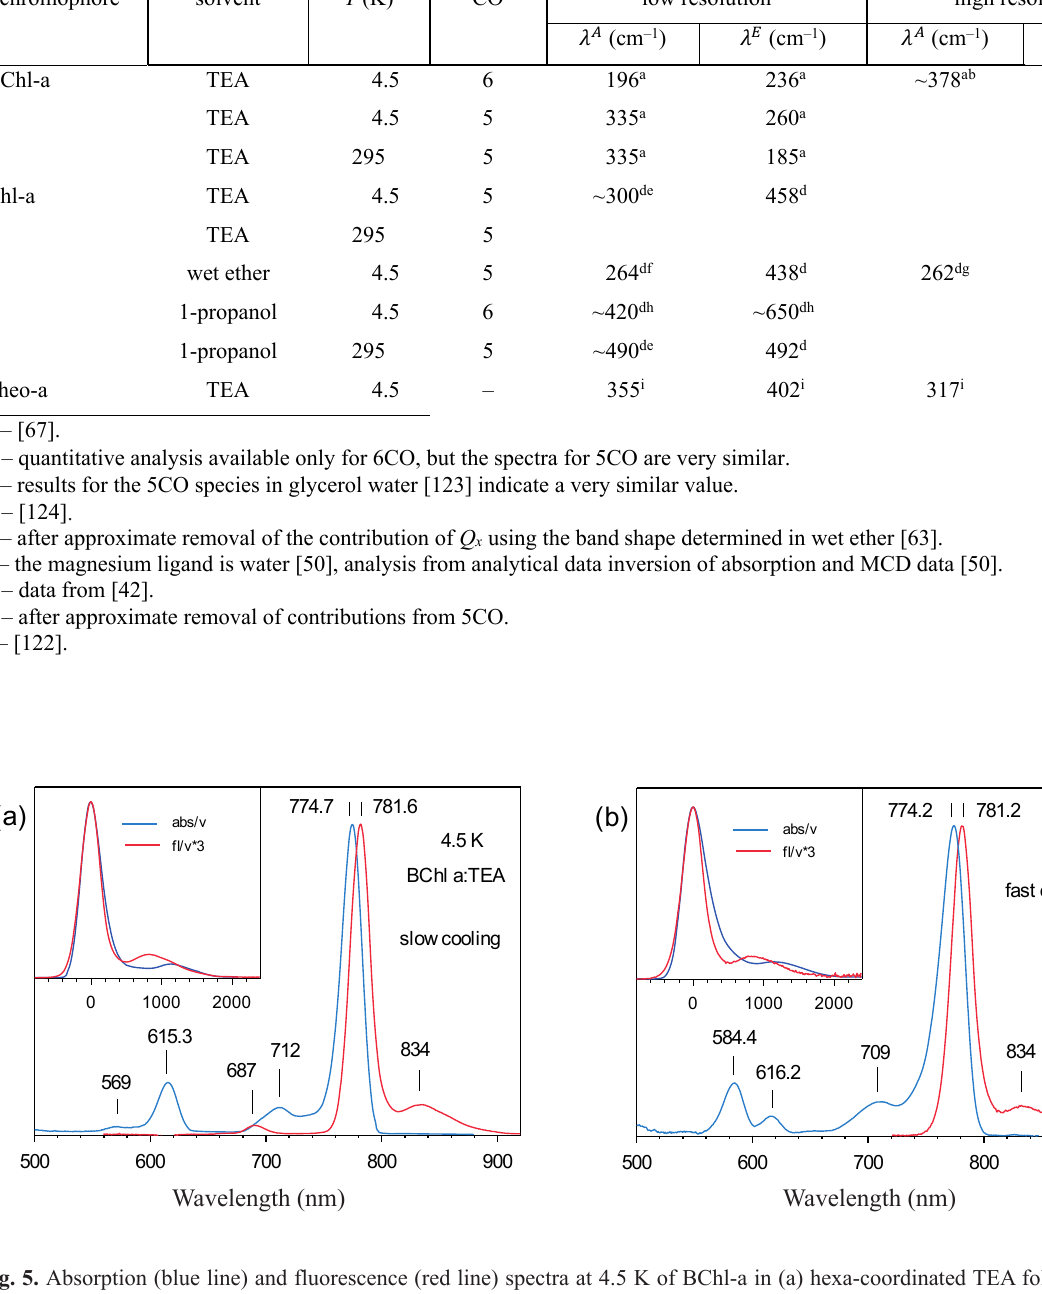
for absorption and 𝜈 − 𝜈 for emission in 00 00